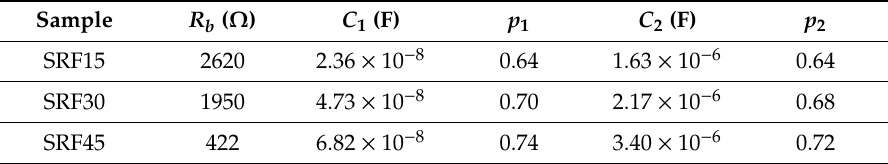
Figure 7. Nyquist plots of ( a ) SRF15, ( b ) SRF30, ( c ) SRF45, and ( d ) the corresponding equivalent circuit. Table 4. Equivalent circuit parameters of low-conductivity